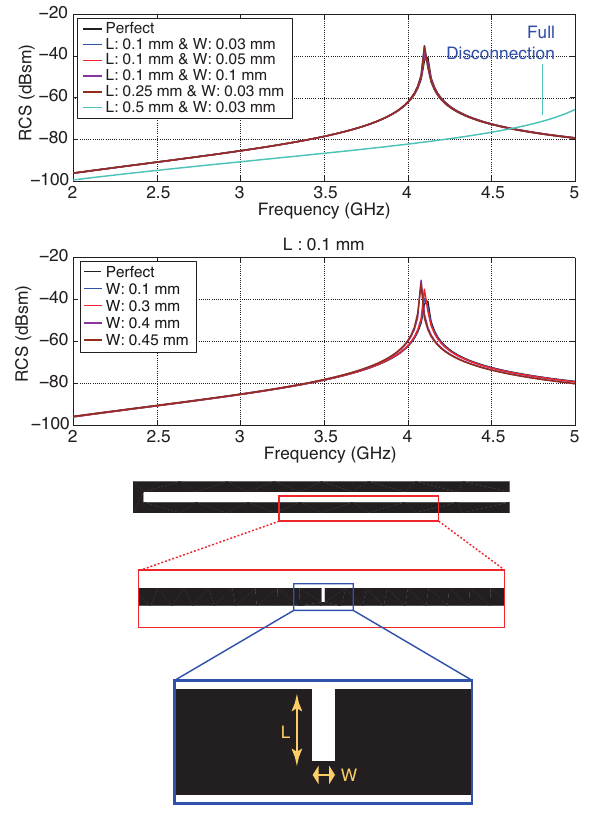
Figure 8: Electromagnetic response of a single resonator when there is a gap of width W and length L on one of the arms.